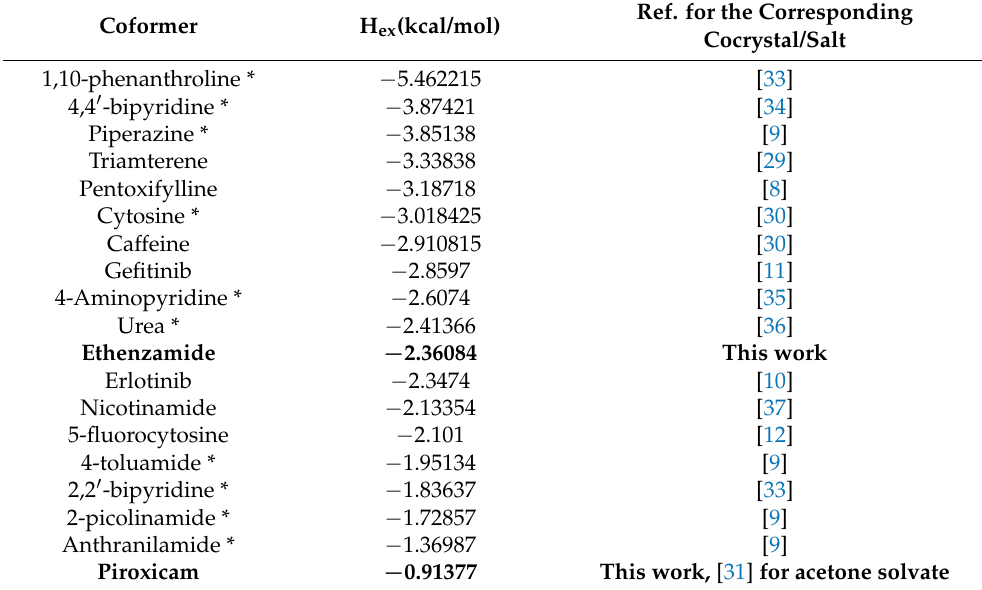
Ref. for the Corresponding Cocrystal/Salt